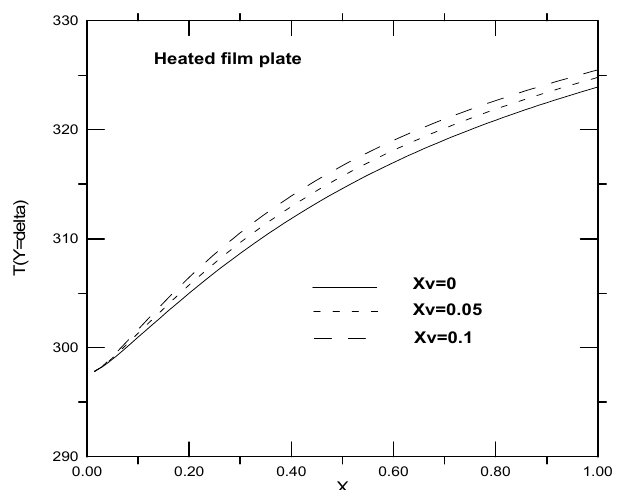
Figure 4. Effect of the nanoparticle volume rate on the interfacial temperature – heated plate case.